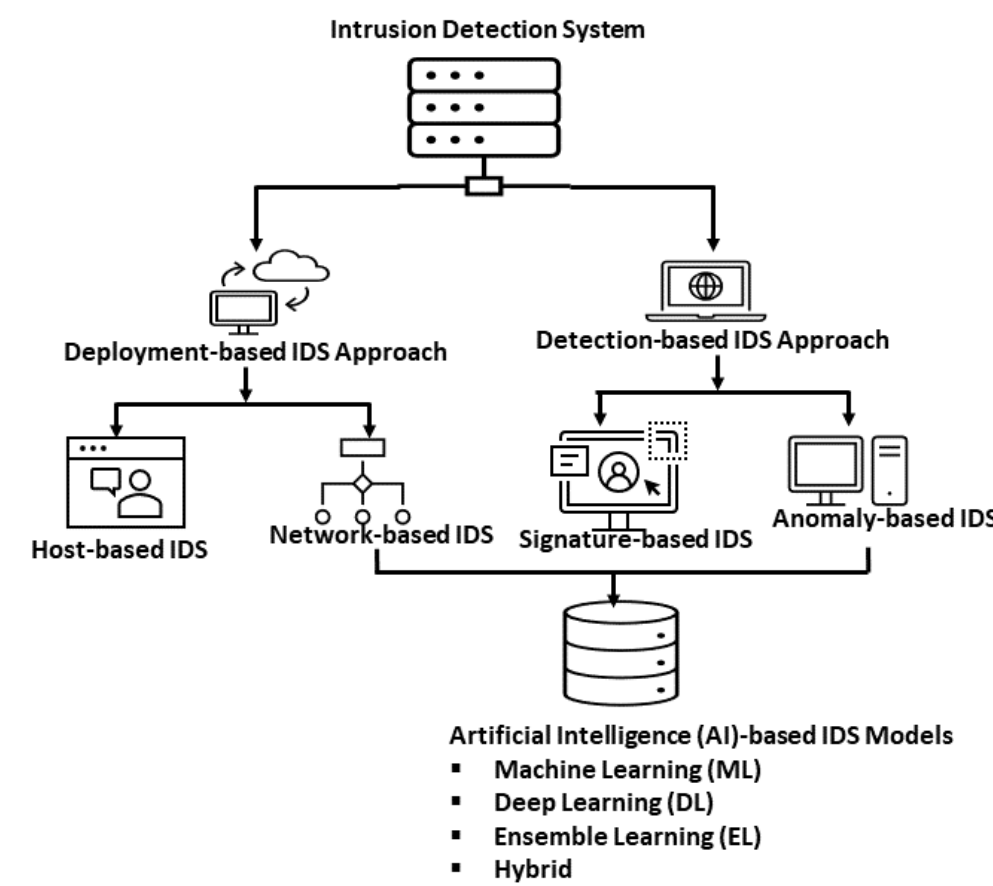
Figure 5. Classification of Intrusion Detection